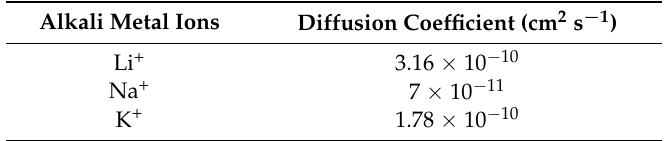
Table 2. Diffusion coefficient of alkali metal ions of Sb 2 S 3 @PPy anode. Alkali Metal